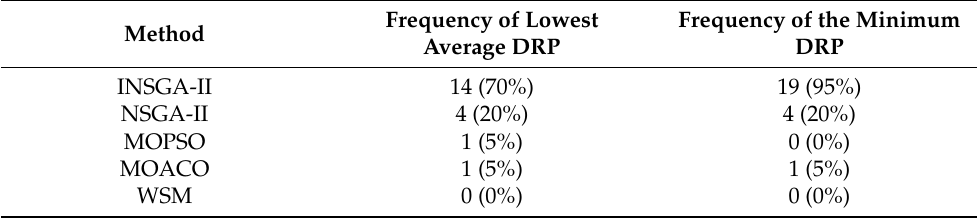
Figure 13. The comparison of average, maximum and minimum DRP value for 20 different tourists (INSGA-II, NSGA-II, MOPSO, MOACO, and WSM). Table 5. The frequency of lowest average DRP and minimum DRP in 20 tourists by INSGA-II, NSGA-II, MOPSO, MOACO,